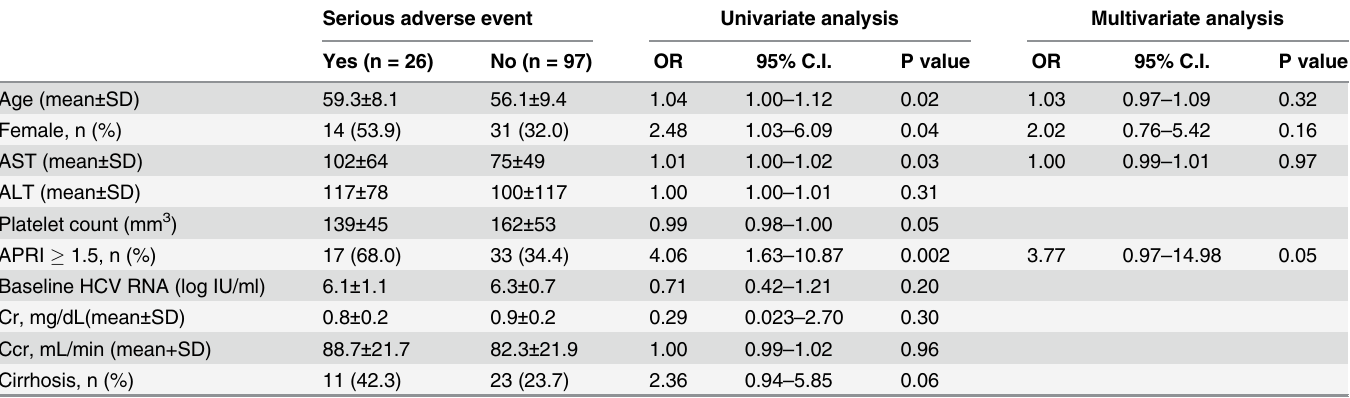
Table 3. Baseline factors associated with occurrence of serious adverse events. Abbreviations: ALT, alanine aminotransferase; Ccr, Creatinine clear- ance rate; APRI, aspartate aminotransferase-to-platelet ratio index.